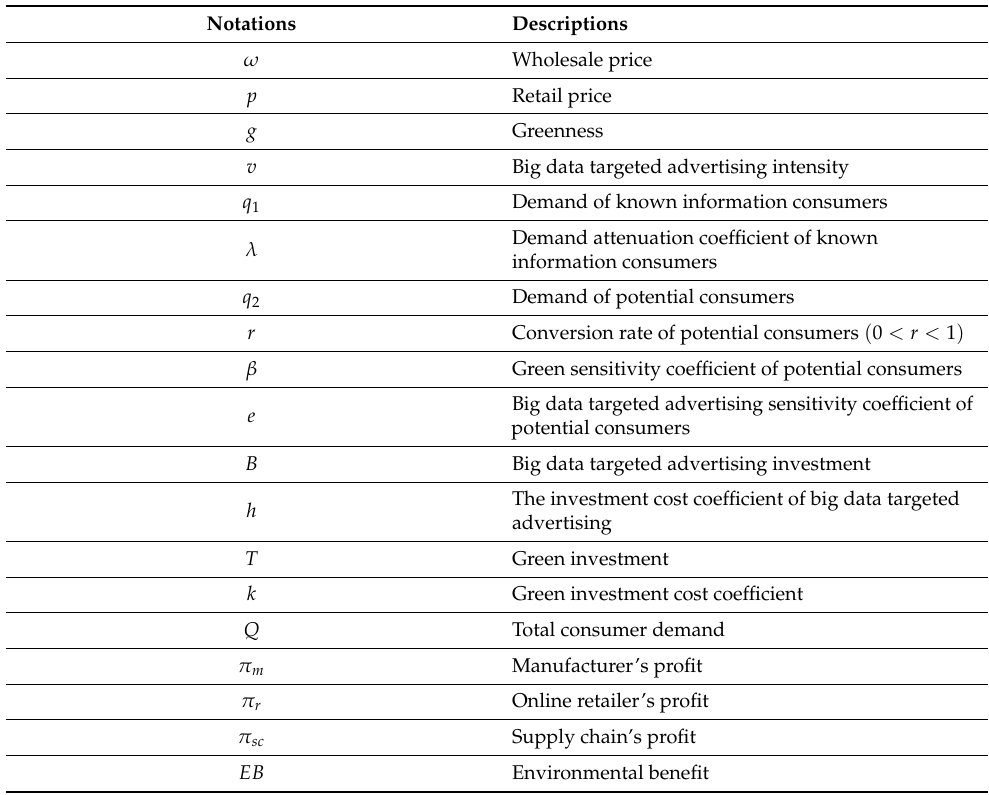
Table 1. Notations and